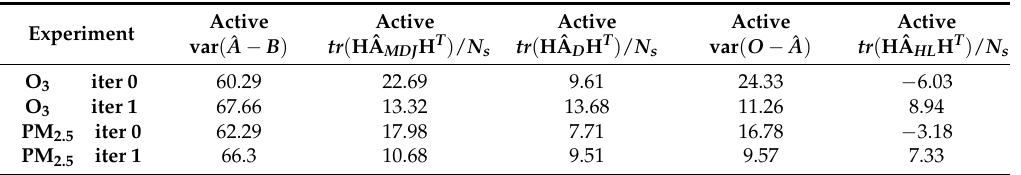
Figure 3. Optimal estimates of 2 o σ , 2 b σ and maximum likelihood estimate of correlation length c L for the first four iterates. Blue, is the optimal background error variance, green, the optimal observation error variance and in red the correlation length (in km, with labels on the right side of the figure). Table 2. Analysis statistics against active observations.